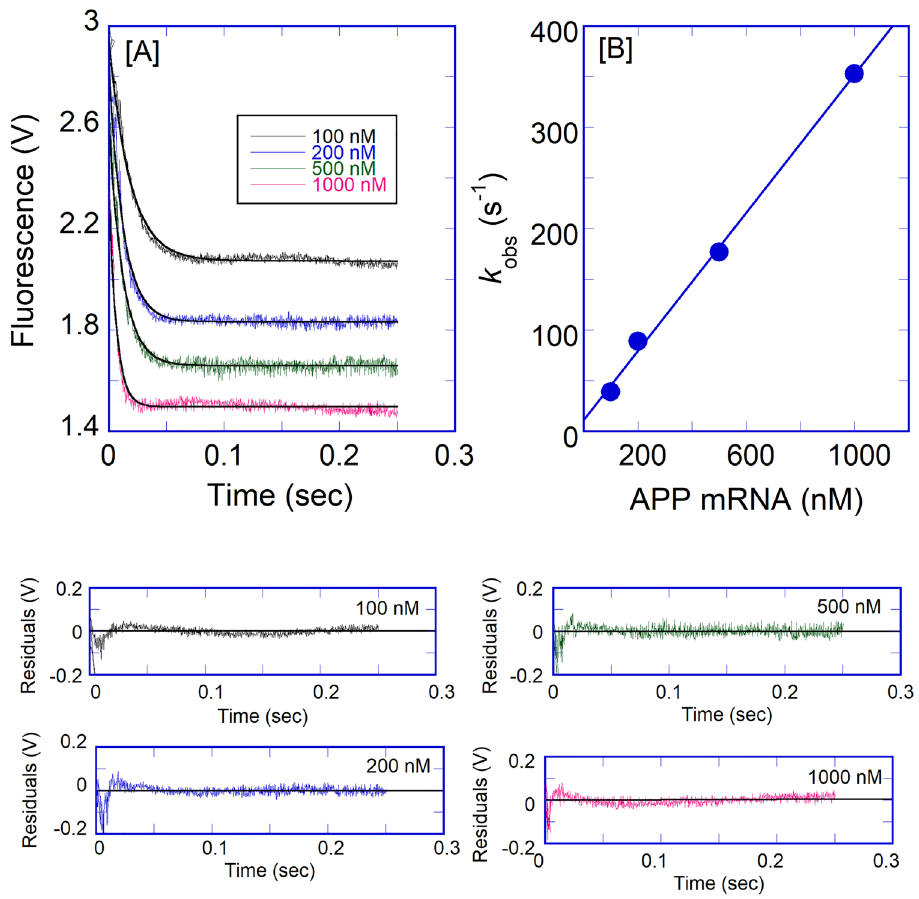
Figure 6. Kinetic rates for the binding of APP IREmRNA to IRP1 protein. ( A ) Typical time course of the intrinsic protein fluorescence intensity of IRP1 (0.1 μM final) decrease caused by binding of APP mRNA at varying concentration (0.1, 0.2, 0.5, and 1 μM final). ( B ) The observed rate constant for the binding of IRP1 to APP mRNA was plotted as a function of increasing concentrations of APP mRNA. The solid line represents the fitted curve for a single exponential function. Residuals for the corresponding fits are shown in the lower